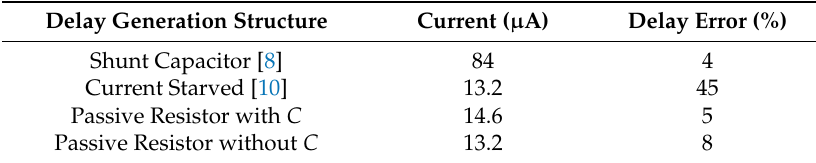
Table 1. Comparison of delay cell structure.